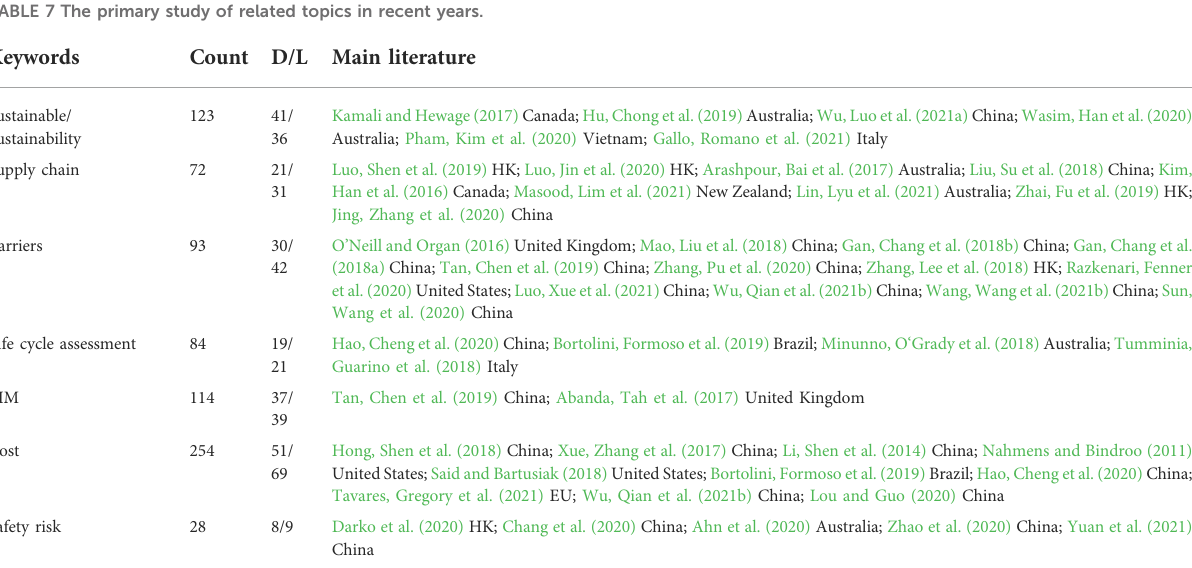
TABLE 7 The primary study of related topics in recent